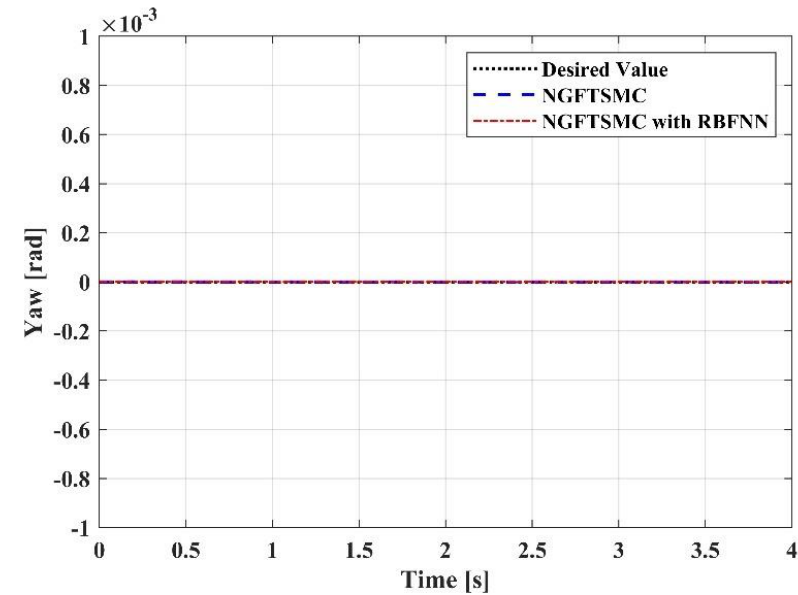
Figure 11. The trajectory tracking results in yaw angel.